Question: Draft a figure caption describing what is shown.
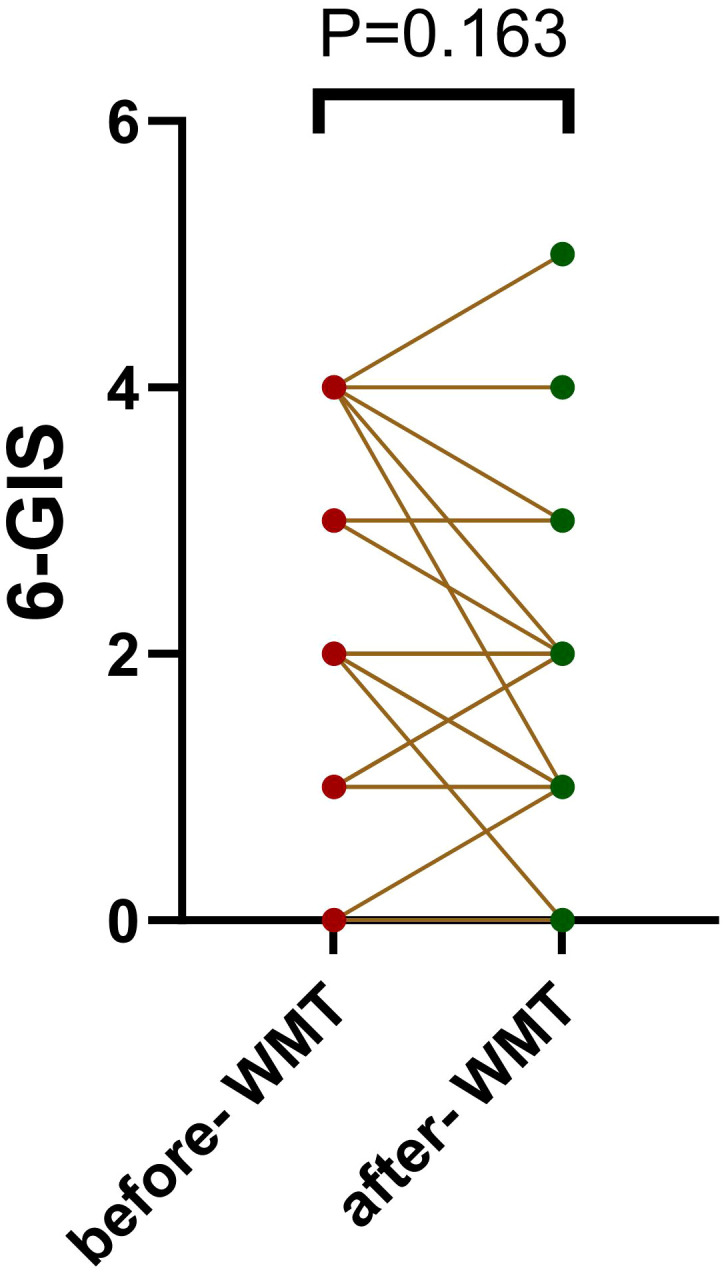
Answer: Comparison of changes in 6-GIS scale scores in children with ASD before and after single-donor WMT.